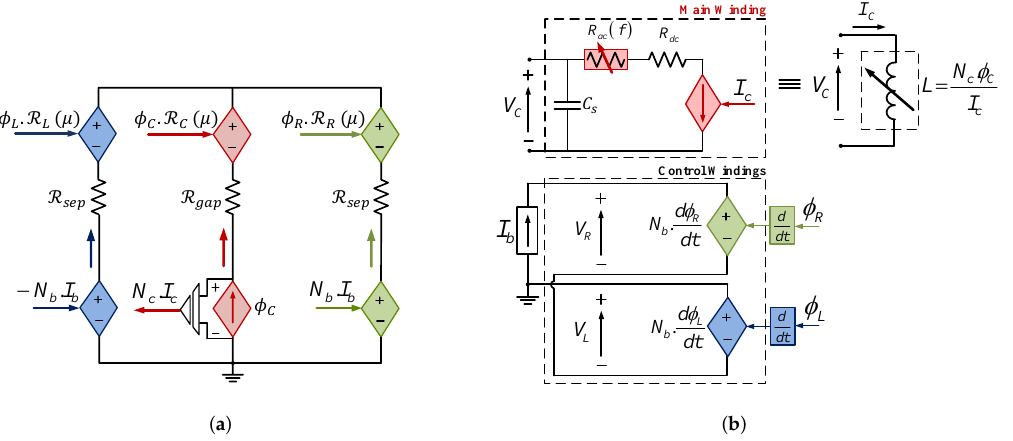
Figure 12. Schematic of the variable inductor model based on the reluctance circuit. ( a ) Magnetic circuit, and ( b ) electric